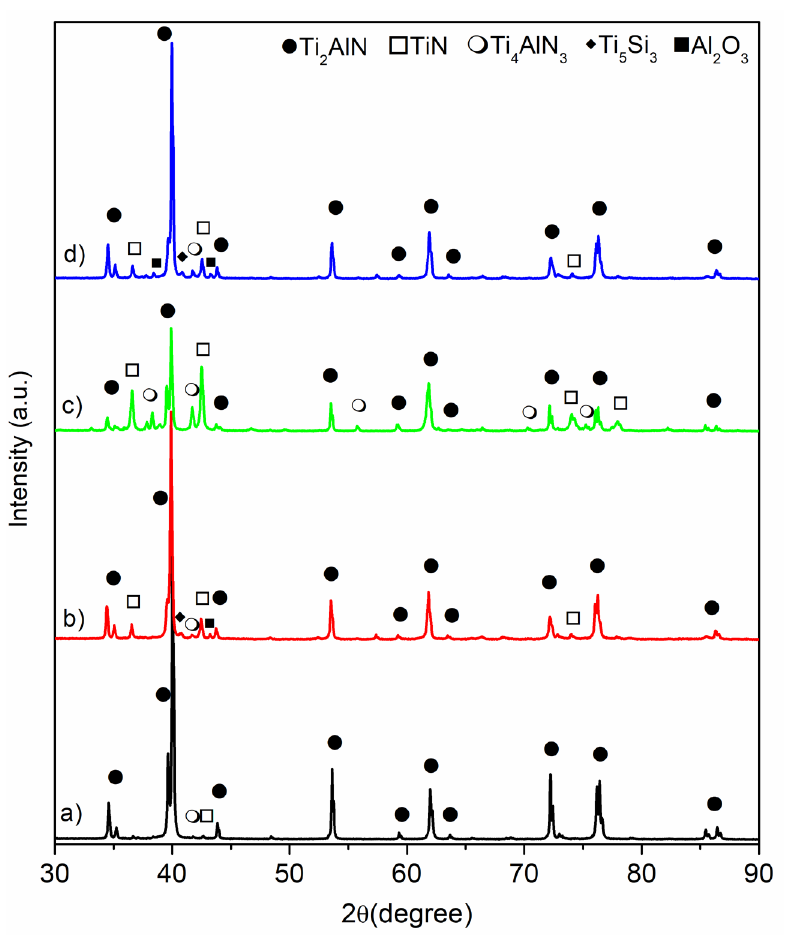
Figure 2. XRD patterns of the bulk Ti 2 AlN MAX phase specimens: ( a ) MAX-1200, ( b ) MAX-1200M, ( c ) MAX-1200N, and ( d ) MAX-1200NM.